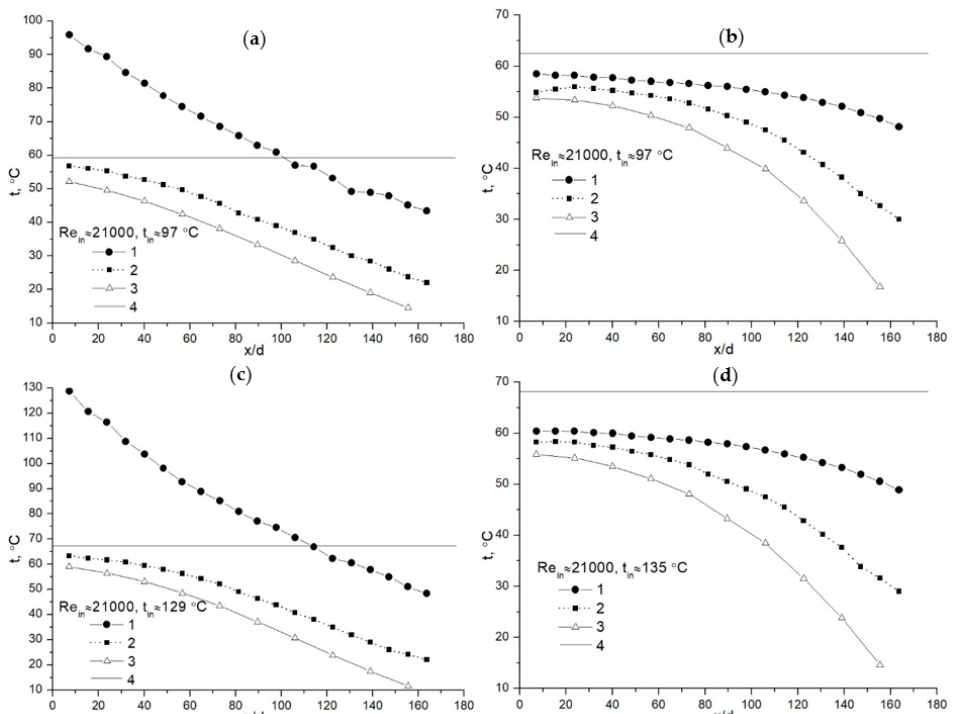
Figure 4. Temperature distribution along the model of the condensing heat exchanger at Re in ≈ 21,000, different flue gas inlet temperatures and in the case when water is not injected ( a ) Re in ≈ 21,000, t in ≈ 97 ◦ C, ( c ) Re in ≈ 21,000, t in ≈ 97 ◦ C and is injected ( b ) Re in ≈ 21,000, t in ≈ 129 ◦ C, ( d ) Re in ≈ 21,000, t in ≈ 135 ◦ C: (1) center of the calorimetric tube, (2) inner wall of the calorimetric tube, (3) cooling water in the middle of the inner and the outer tubes, (4) dew point temperature at the inlet into the calorimetric tube.